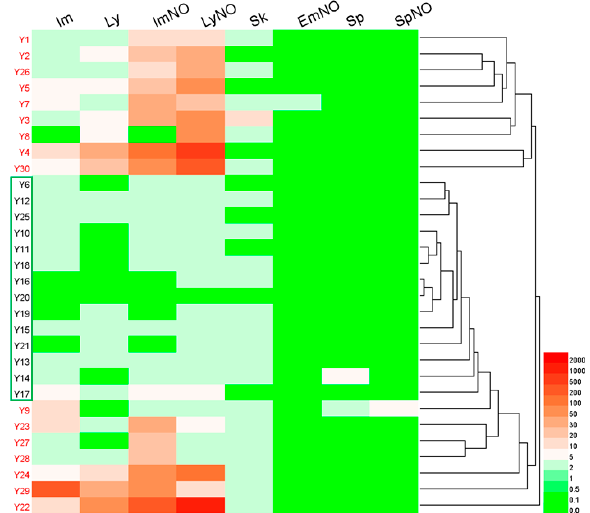
Figure 8. Hierarchical clustering heatmap of the detected PAs in A. capillaris . The total PAs concentration of the sample batches in red font exceeded the baseline, but the sample batches in black font and with green boxes did not.